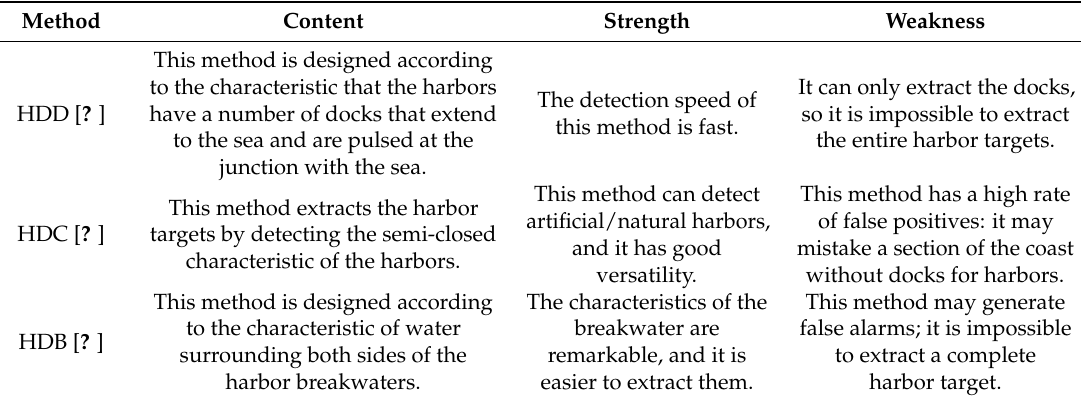
Table 1. The advantages and disadvantages of some